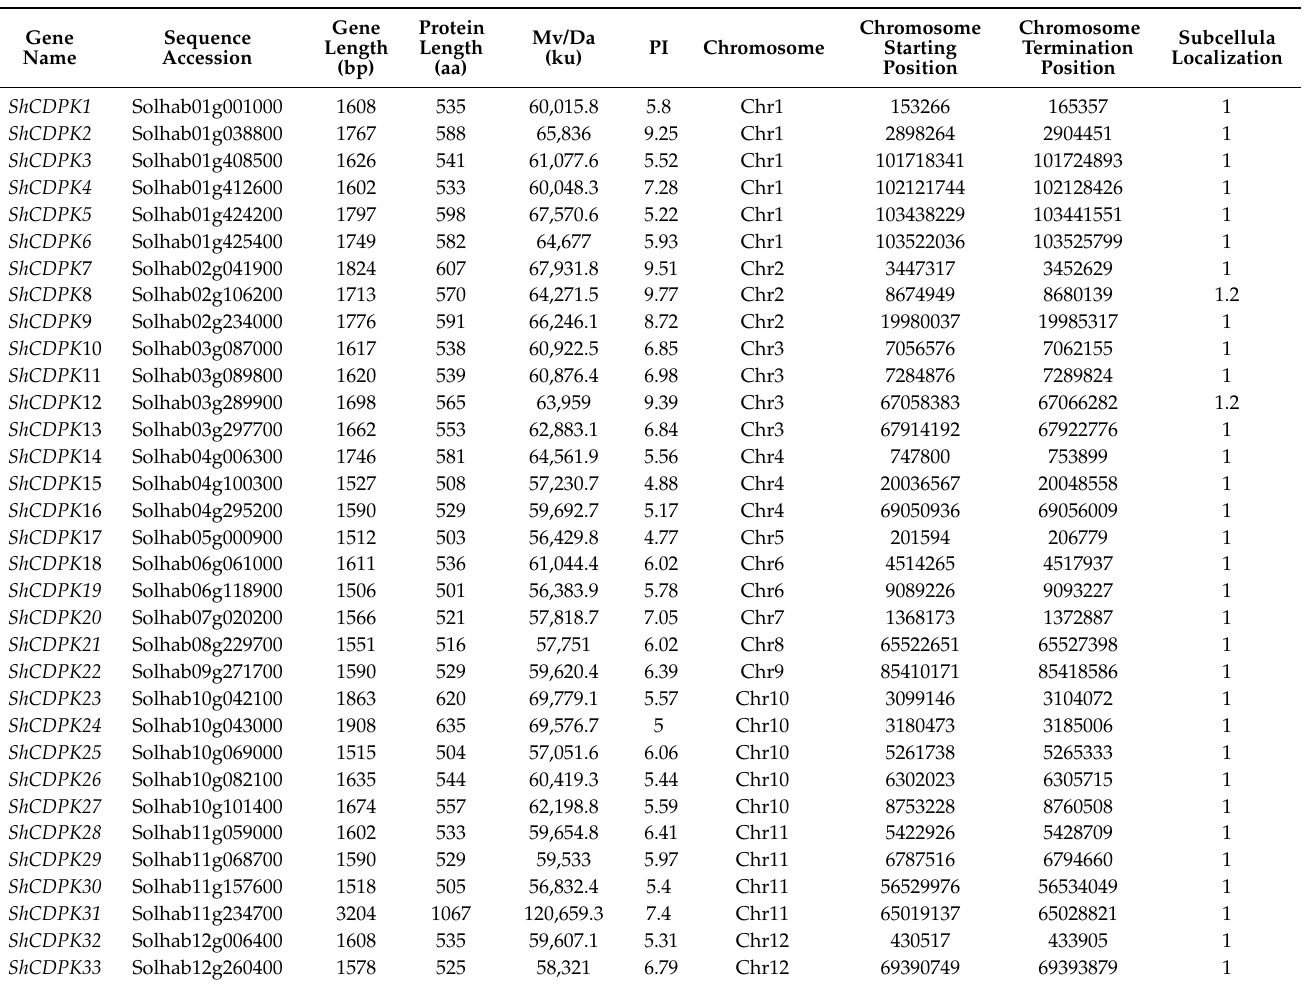
Table 1. Characteristic of CDPK gene family in Solanum habrochaites